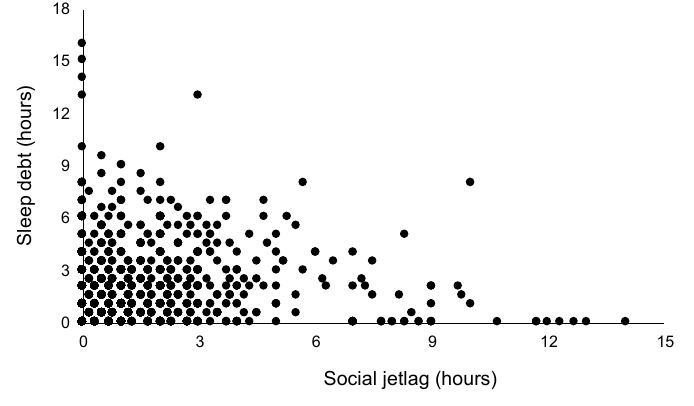
Figure 3. Scatter plot: Association between sleep debt and social jetlag.